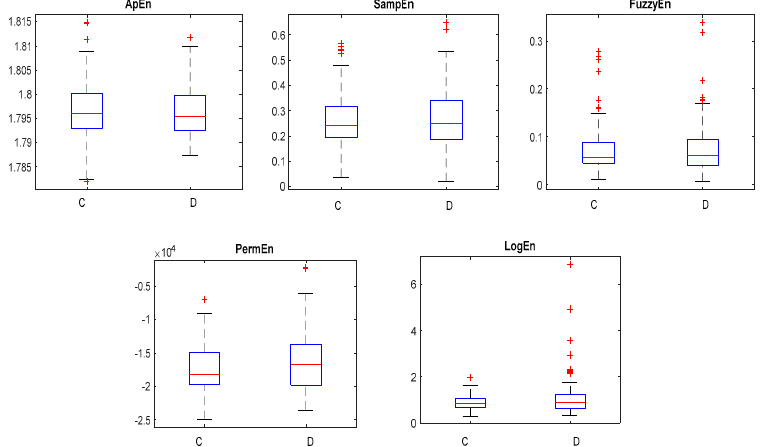
Figure 7. The box plots of the C and D classes in the University of Bonn dataset.